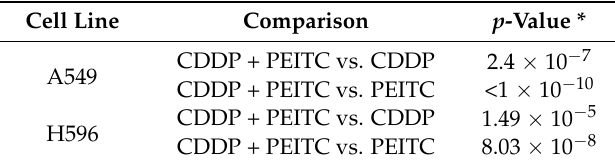
Table 3. Effect of cisplatin (CDDP) and phenethyl isothiocyanate (PEITC) combination therapy.